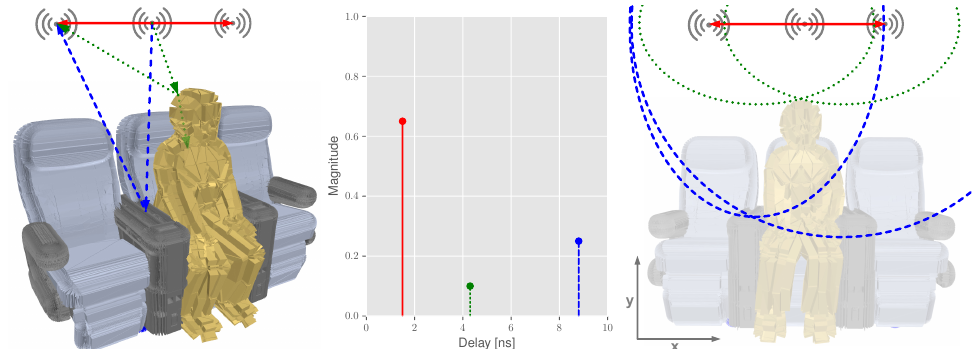
Figure 2. Multipath propagation in the aircraft cabin: 3D model of a seat row including a passenger, the theoretic CIR and the geometric interpretation using ellipses. Direct paths are given in red, reflection paths in green and